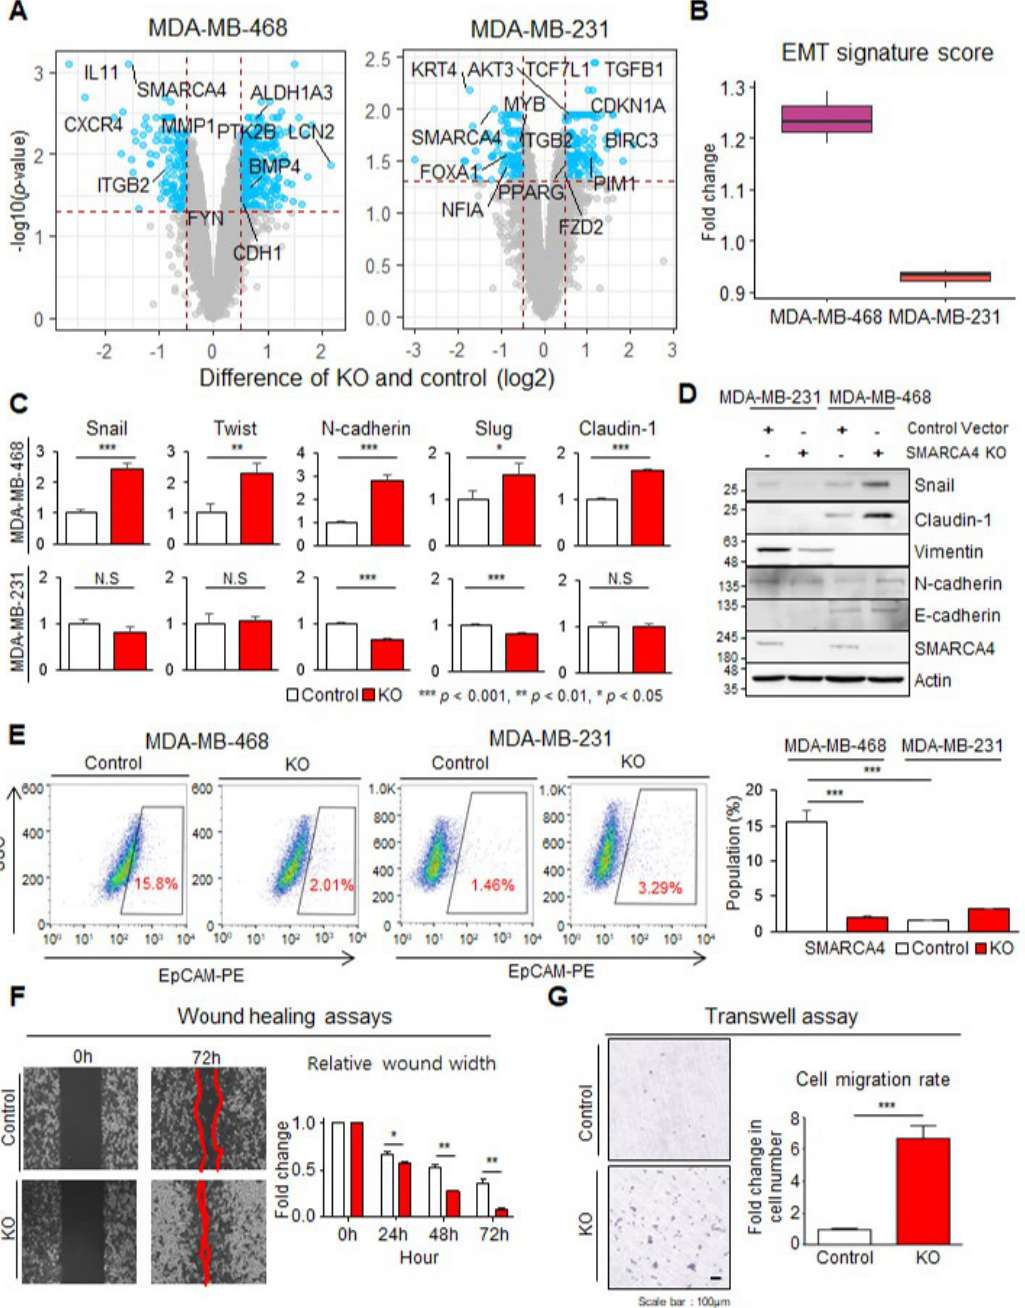
Figure 4. EMT characteristics induced by SMARCA4 KO. ( A ) Volcano plots of DEGs based on RNA-seq analysis of control and SMARCA4 KO cells. The X-axis indicates the log2FC between SMARCA4 KO and control cells. The Y-axis is the − log10- scaled p -value calculated using the limma test. DEGs involved in EMT and the TGF- β pathway are labeled. ( B ) Boxplot of the fold change (FC) in EMT signature score between the KO and control versions of MDA-MB-231 and MBA-MD-468 cells. EMT scores were calculated from signature genes ( n = 42) [31], and fold changes in scores were acquired to compare